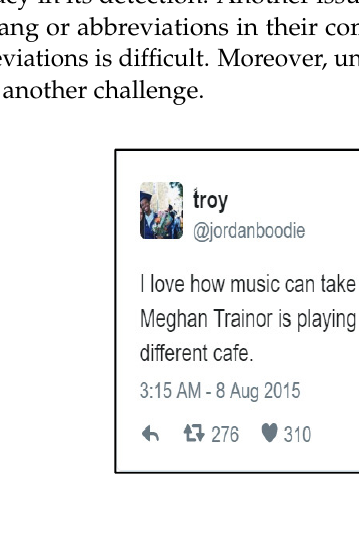
Figure 1. ( a ) Tweet about politicians [10]. ( b ) Tweets about celebrities [11].